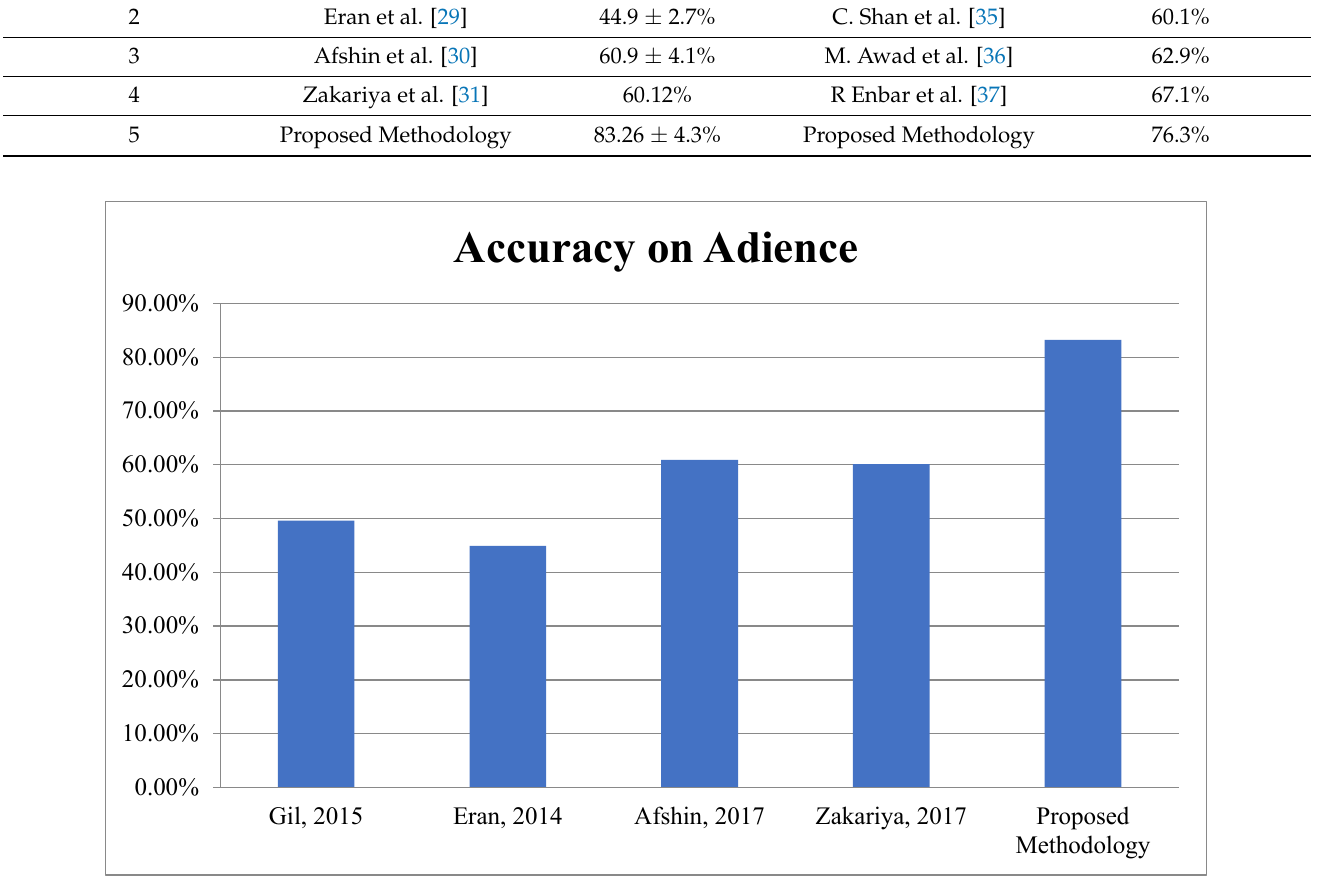
Figure 13. Accuracy Comparison for Age Classification on Adience.